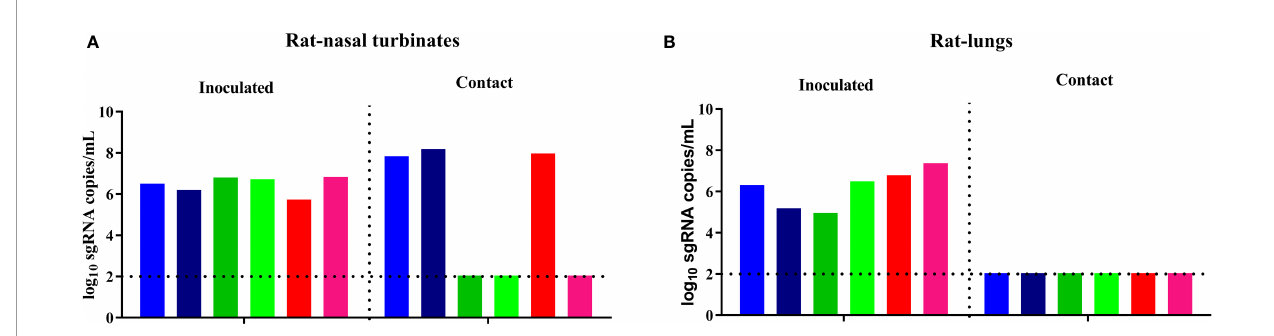
FIGURE 3 | SARS-CoV-2 B.1.351 variant transmission in male rats. The dotted line represents the detection limit. Viral sgRNA copies (log the nasal turbinates (A) and lungs (B) of the inoculated rats and the contact rats. Every two rats in each of the three subgroups are shown in similar colors, such as red, blue and